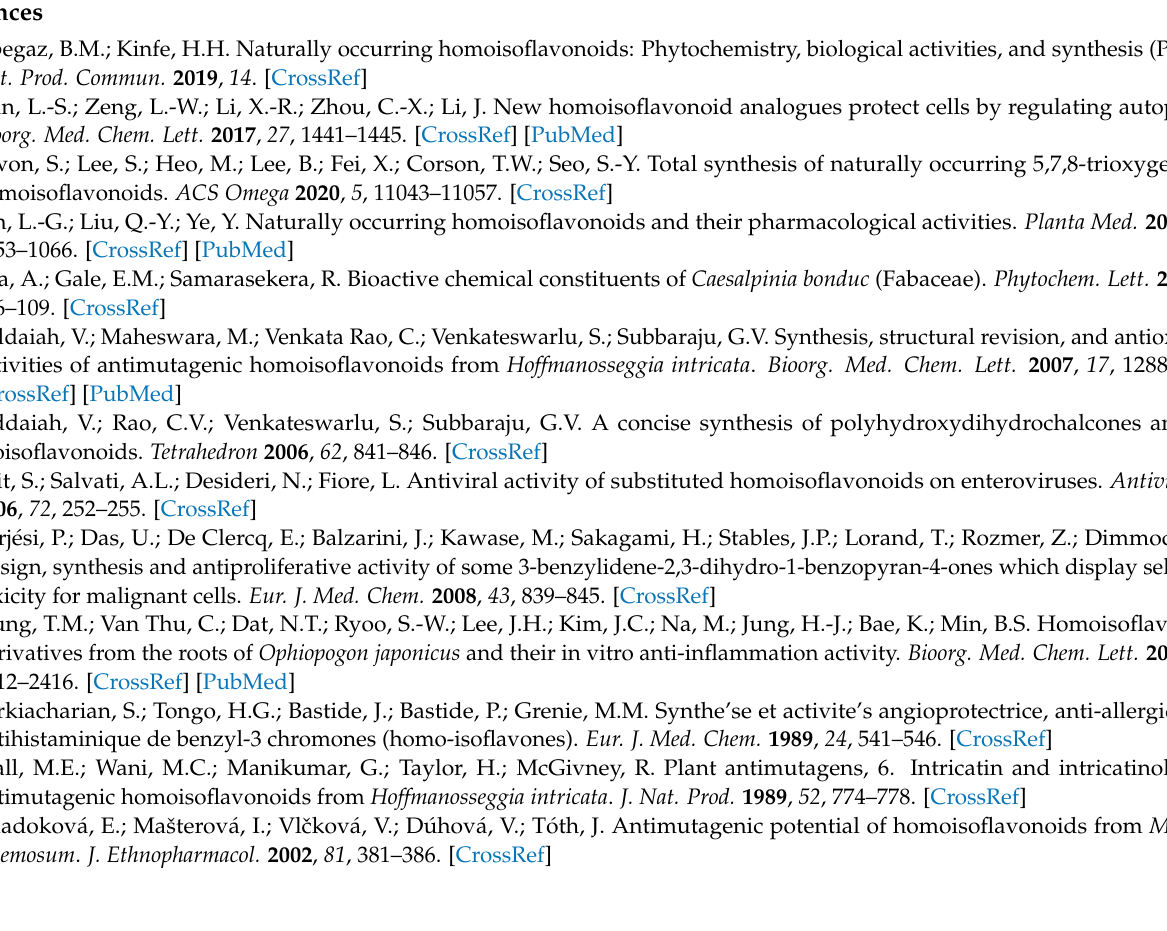
Table S2: Homoisoflavonoid derivatives isolated from Fabaceae family, Table S3: Homoisoflavonoids isolated from plant families except Asparagaceae and